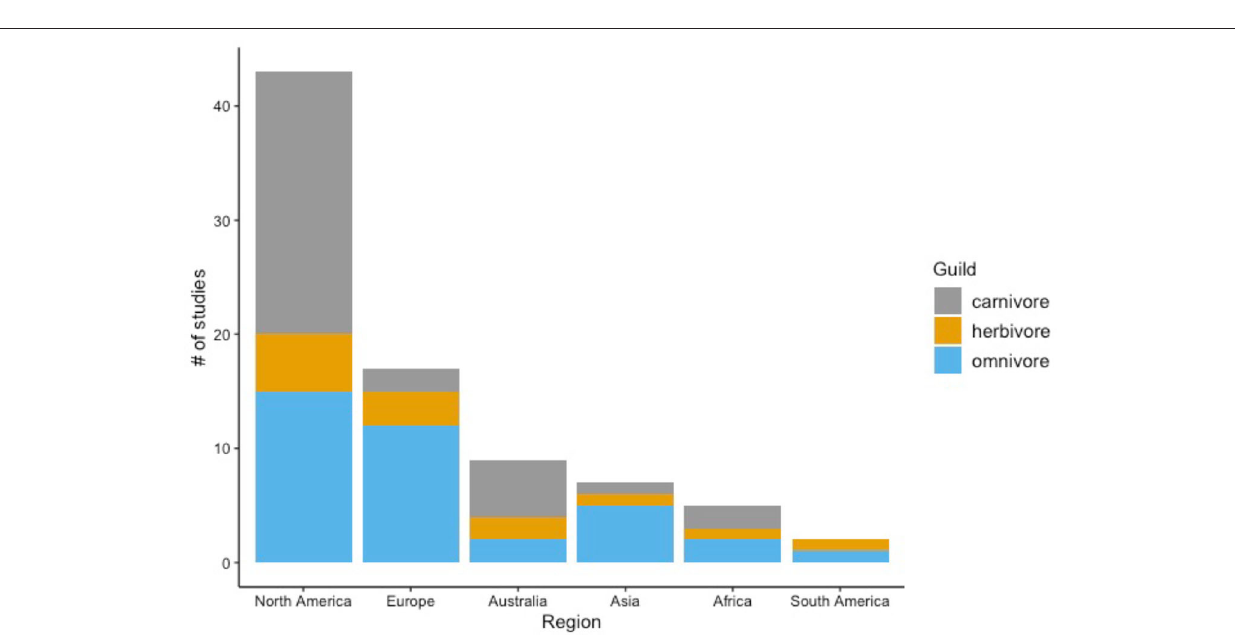
responses) was the most frequently observed, followed by increased nocturnality ( n = 9; 9%), diet preference changes ( n = 9; 9%), and shift in resource selection ( n = 9; 9%). All observed changes in alert behavior were categorized as regulatory